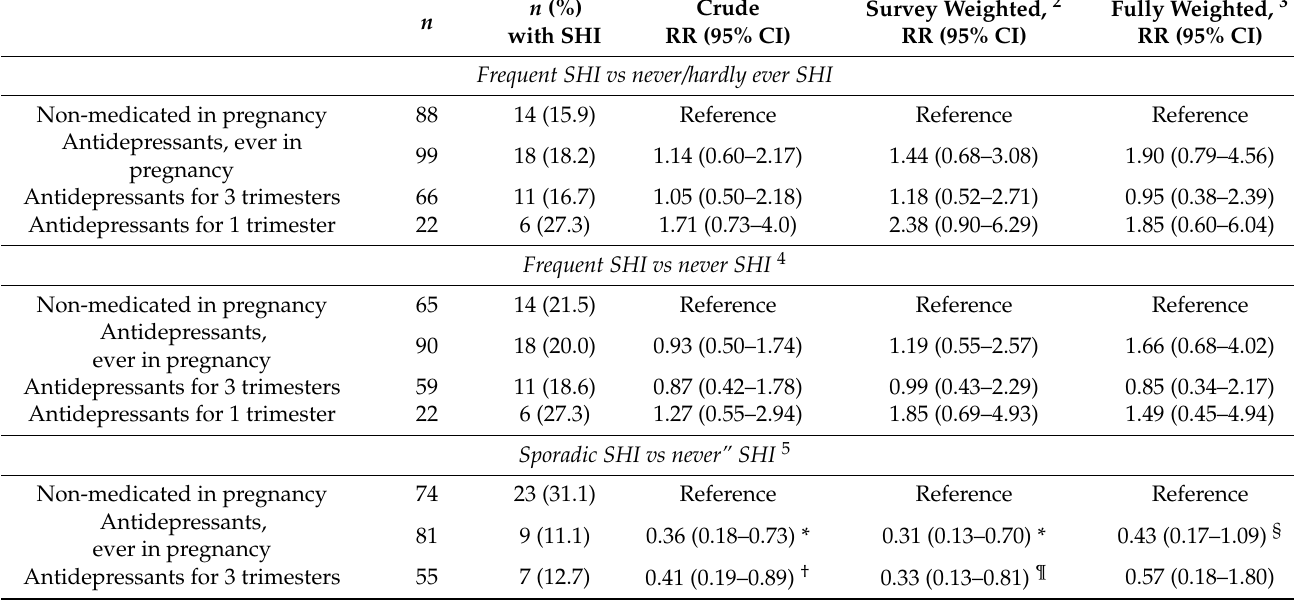
Table 3. Association between antidepressant treatment during pregnancy and postnatal SHI 1